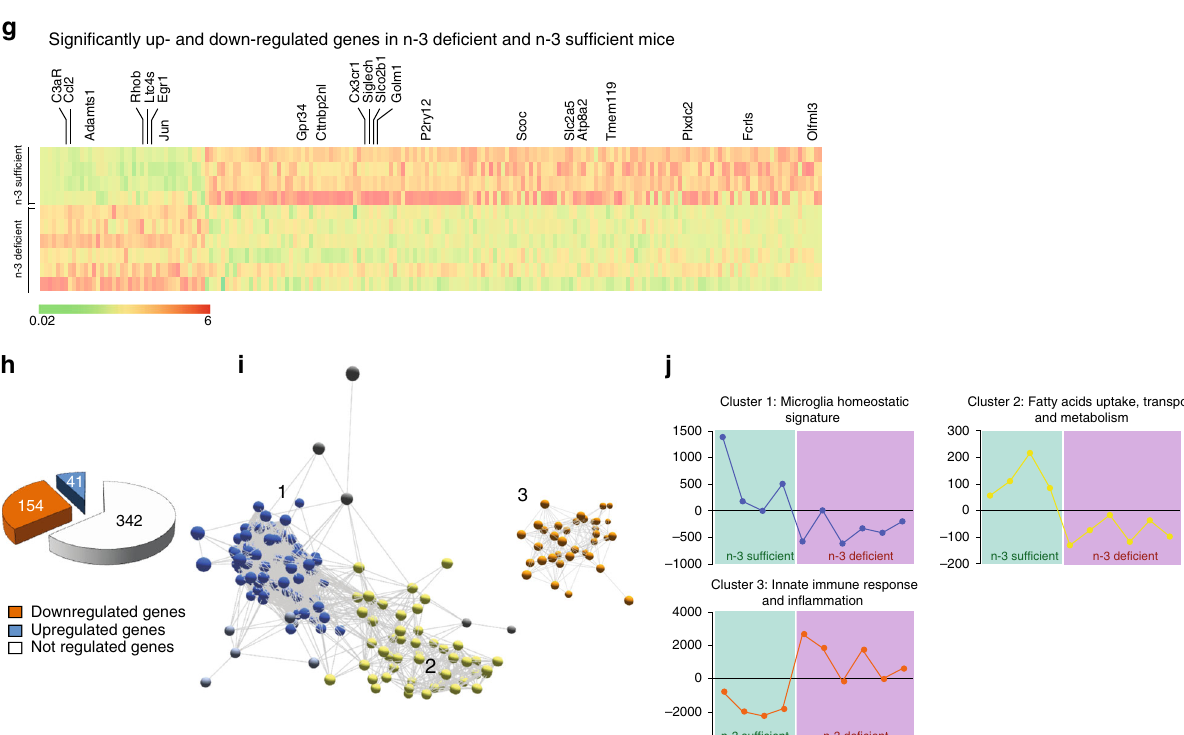
To directly evaluate the effect of microglial and synaptosome fatty acid alterations on microglial phagocytic activity, we developed an ex vivo assay in which we exposed freshly isolated de fi cient pHrodo-labelled synaptosomes (Fig. 3c). We measured microglial phagocytic activity based on the level of cellular accumulation of pHrodo fl uorescence (Fig. 3c). Phagocytosis was